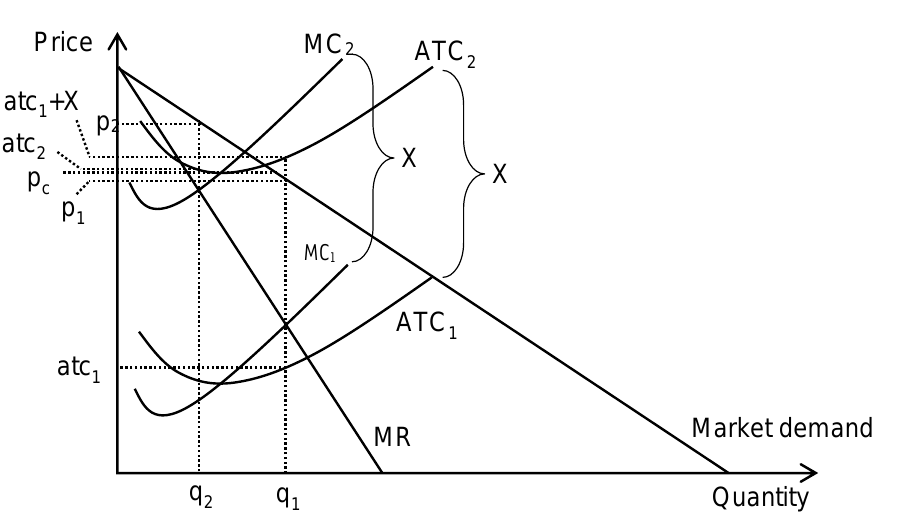
FIGURE 1: Unconstrained monopoly with a special variable cost advantage and increasing marginal costs Source: Author’s